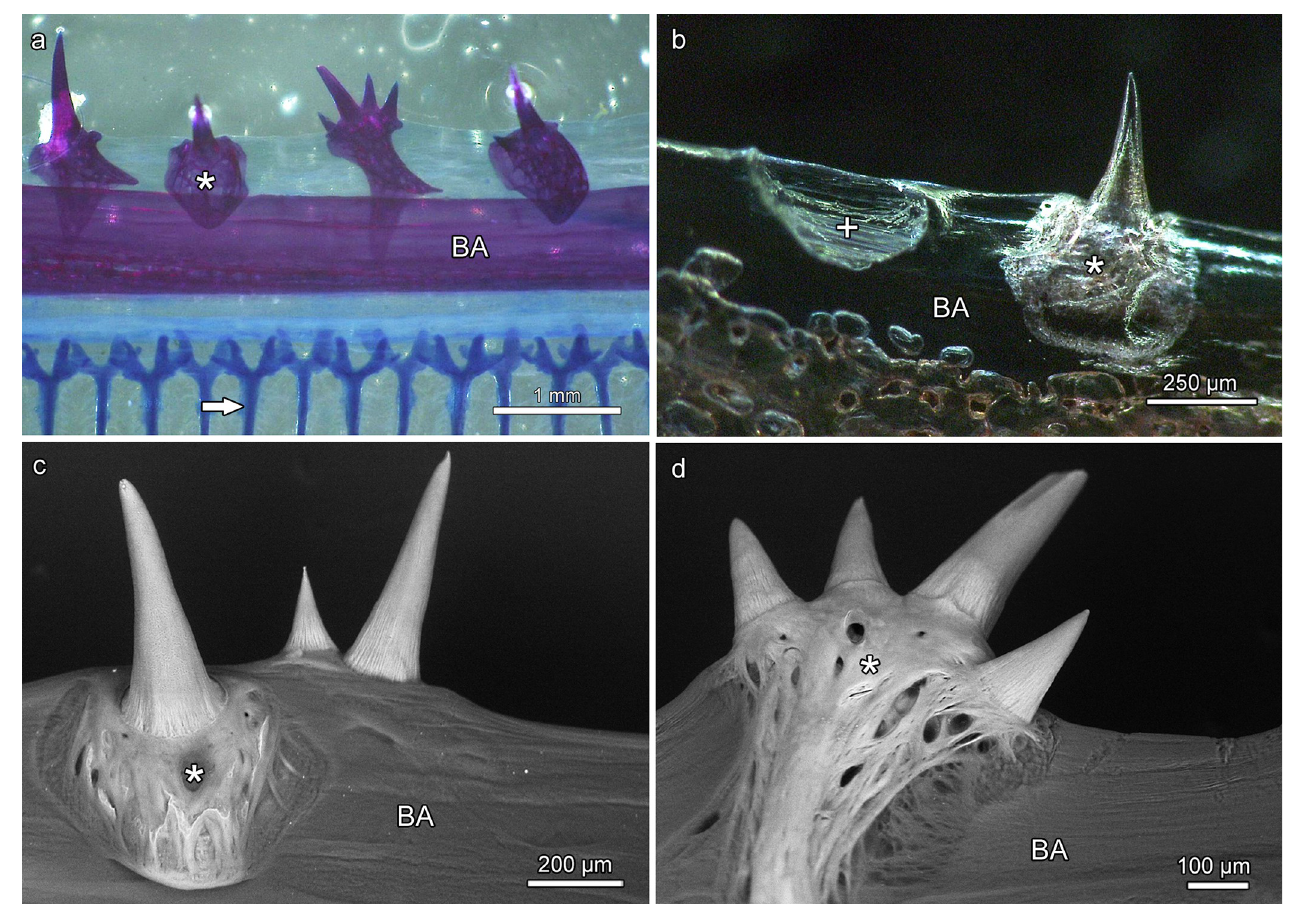
Fig 13. Teeth on the branchial arches of Anoplogaster cornuta . (a) Single or multiple monocuspid teeth are attached to trabecular bony plates (asterisk) located on a branchial arch (BA). Arrow: Gill filament. Cleared and stained (Alizarin red S, alcian blue 8 GX) specimen. (b) Bony plate (asterisk) with single attached tooth and cup-like notch (+) on a branchial arch (BA) where a tooth-bearing bony plate has been lost. Unstained, macerated specimen. (c) and (d) SEM-BSE images of single (c) or multiple (d) monocuspid teeth attached to bony plates (asterisks) with trabecular architecture. Note ring-like seams at the attachment sites of the teeth on the bony plates. The bony plates are fixed by collagen fibers to the branchial arches (BA).